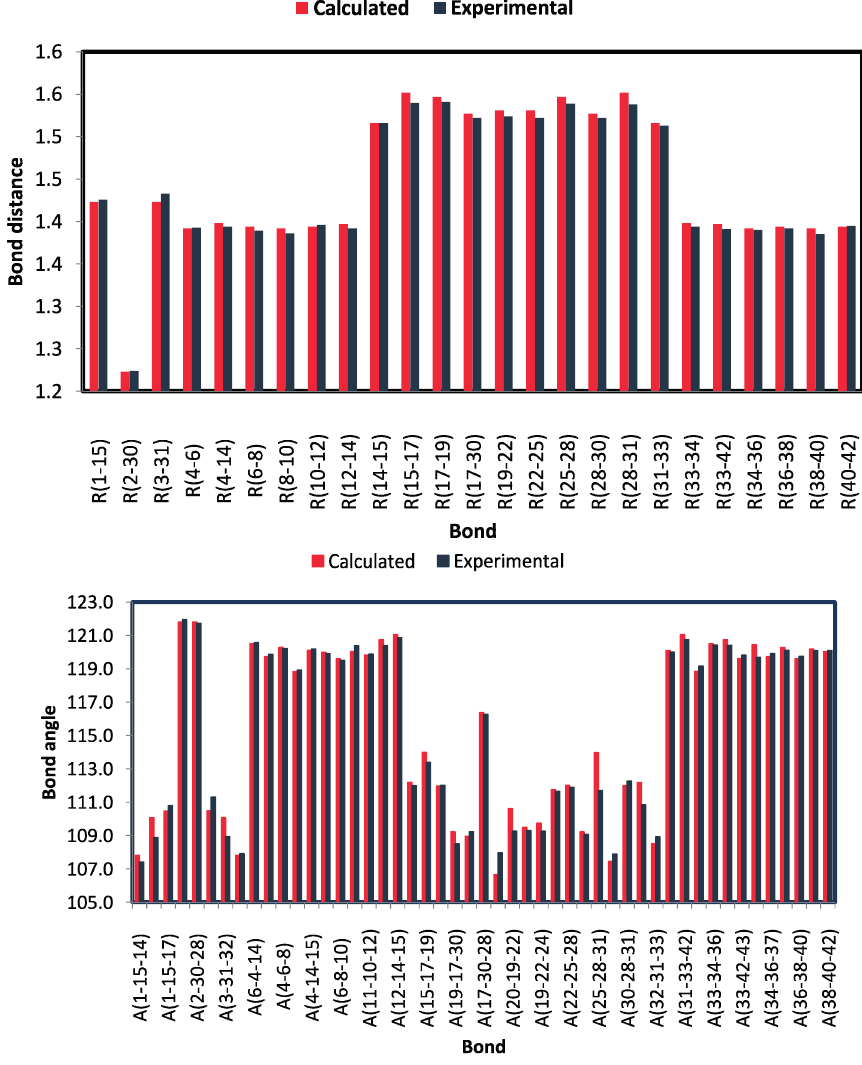
Figure 5. Comparison between the calculated and experimental geometric parameters (bond distances and angles) of the studied